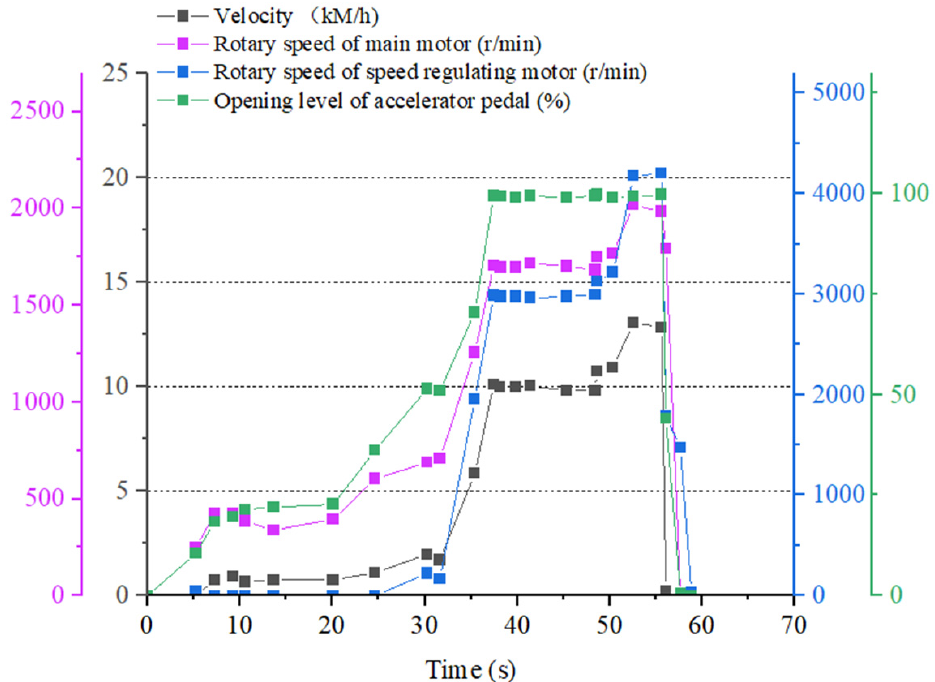
Figure 17. Curves of speed, main motor speed, governor motor speed, and accelerator pedal opening.